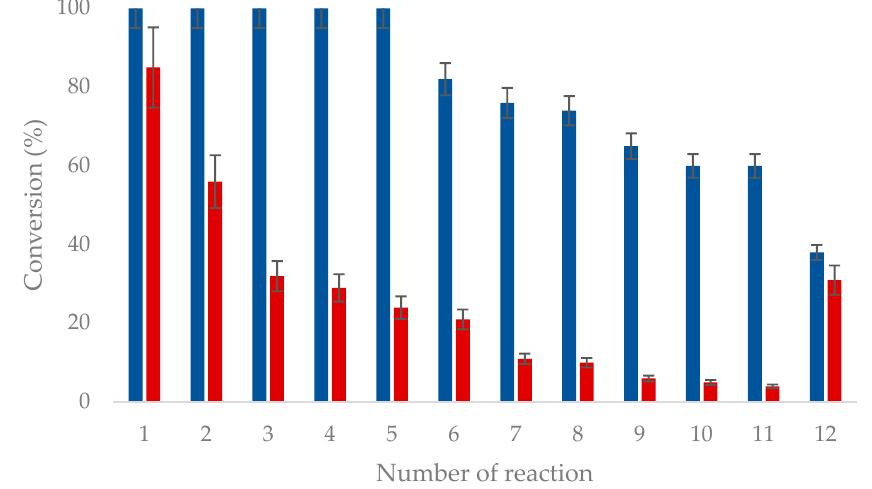
Figure 3. Recycling of immobilized OYE3-GA (blue) and OYE3 / GDH-EziG (red). Experimental conditions as reported in Scheme 3.